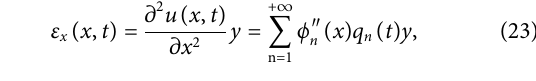
Frontiers in Materials |